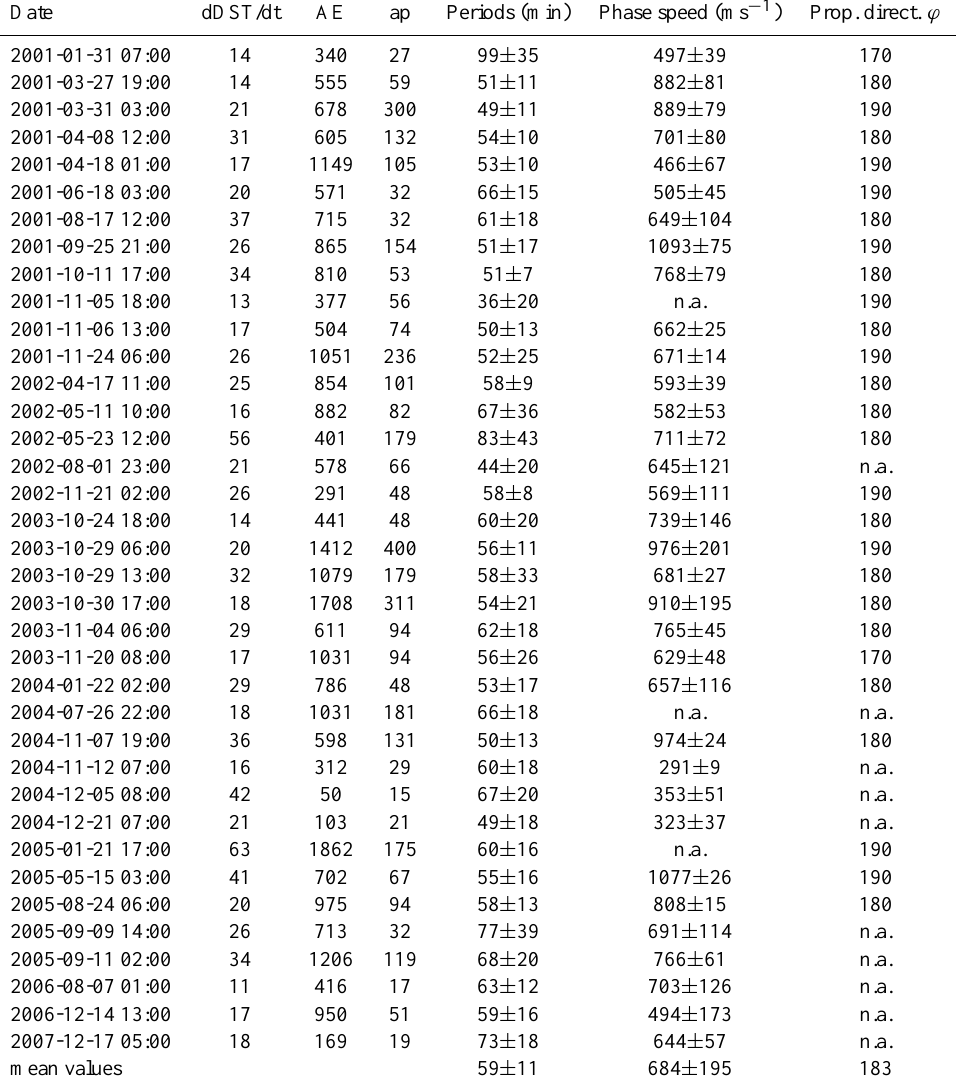
Table A1. List of the results of the analyses. 1st column: dates of analysed storm events; 2nd column: derivative of D st ; 3rd col- umn: AE index; 4th column: ap index; 5th column: mean and standard deviation of the periods observed at 46 ◦ N/8 ◦ E, 46 ◦ N/12 ◦